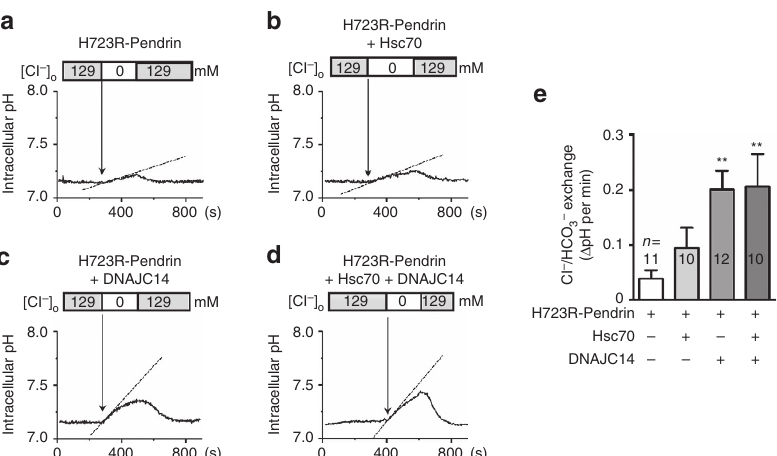
Figure 8 | Rescue of anion exchange activity of H723R-pendrin by DNAJC14. PANC-1 cells were transfected with the indicated plasmids and Cl (cid:2) /HCO 3 (cid:2) exchange activity was examined. Representative traces are shown in a – d, and a summary of multiple experiments is depicted in e . Overexpression of DNAJC14 alone, but not Hsc70 alone, significantly increased the Cl (cid:2) /HCO 3 (cid:2) exchange activity in H723R-pendrin-expressing PANC-1 cells. ** P o 0.01 by one-way analysis of variance, difference from H723R-pendrin alone (lane 1), the number of replicates ( n ) is presented in each